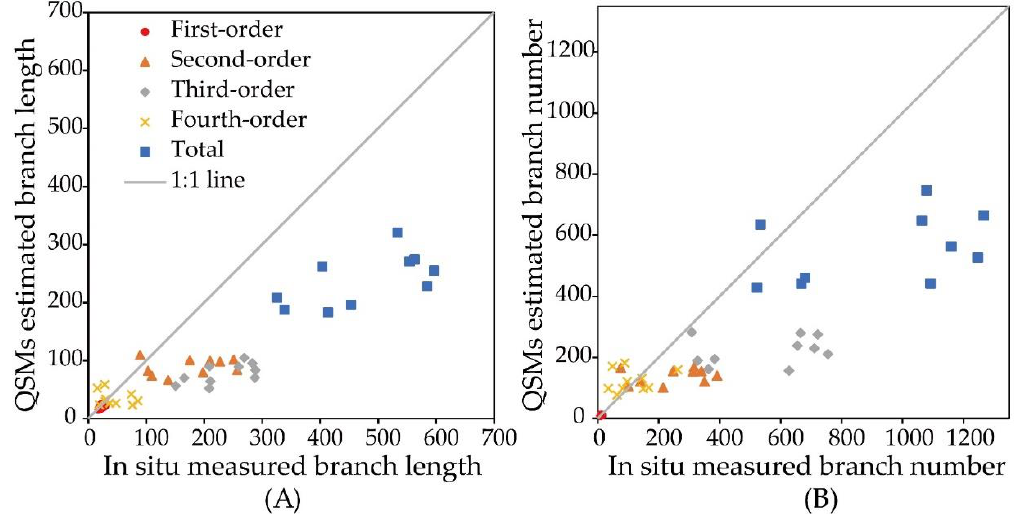
Figure 8. Comparison of in situ measured branch information (length/number) with branch information from QSMs based on backpack-LiDAR. ( A ) Comparison of branch length and total length by branch grade; ( B ) comparison of branch number and total number by branch grade.